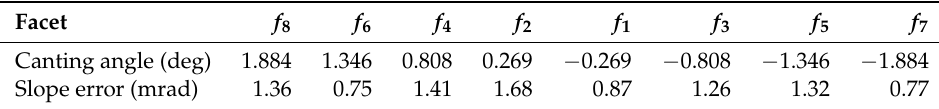
Table 2. Canting angle of the mirrors corresponding to 21st March, at solar noon, and slope errors. Facet f 8 f 6 f 4 Canting angle